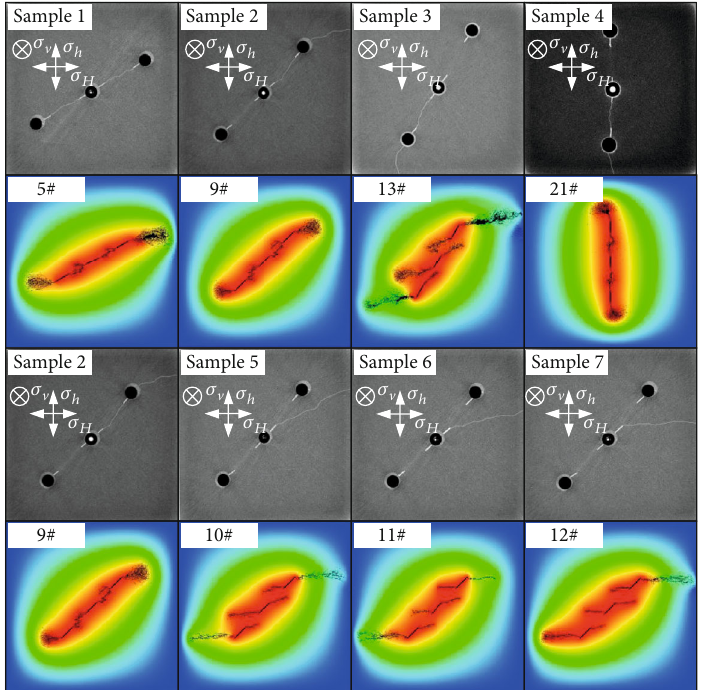
Figure 13: Comparison of crack propagation morphology between numerical calculations and physical experiments [18].